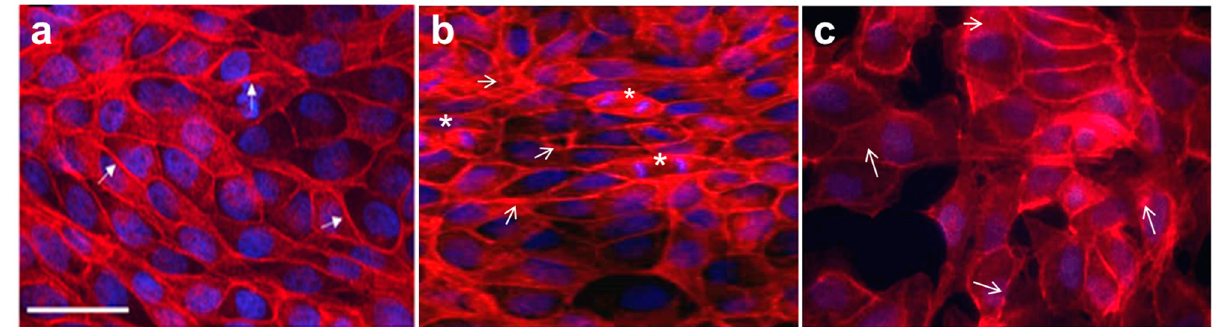
Figure 2. F-actin staining (red color) of untreated and treated with 5 and 20 µg/mL myconoside MDCKII cells. The blue color matches to the cellular nucleus. Untreated MDCKII cells ( a ) and myconoside-treated ones ( b , c ). The arrows show the F-actin fibers and the asterisks—cell division. A total of 5 µg/mL myconoside stabilizes the F-actin network ( b ), while 20 µg/mL induces a granular pattern of F-actin (( c ), arrows). Scale bar: 50 µm.